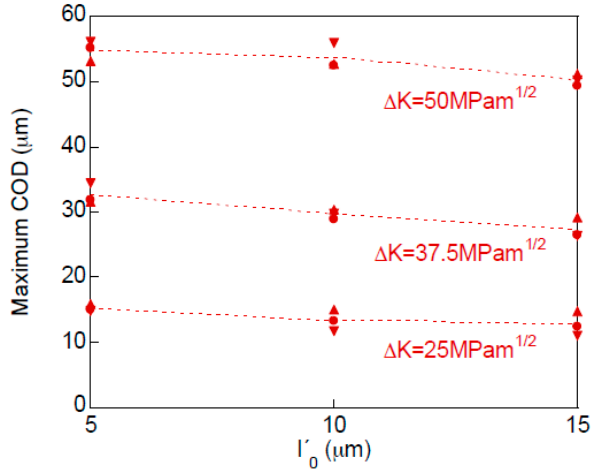
Figure 10. Maximum crack opening displacement (COD) in the kinked crack tip after 20 loading cycles, as a function of the projected length l 0 ′ , for different Δ K (SIF range) levels.